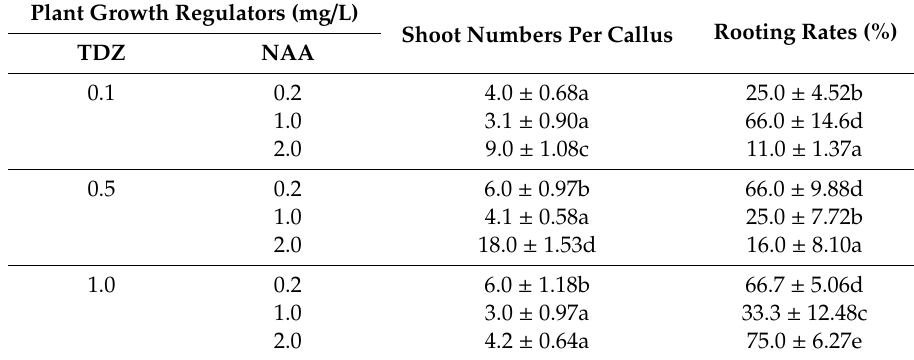
Values represent the mean ± standard deviation. Values within the same column followed by the same letter are not significantly di ff erent according to the least significance at p < 0.05 (Duncan 1955). Each treatment consisted of three replications of 100 explants each. All data were collected 8 weeks after being inoculated in the medium supplemented with PGRs (plant growth